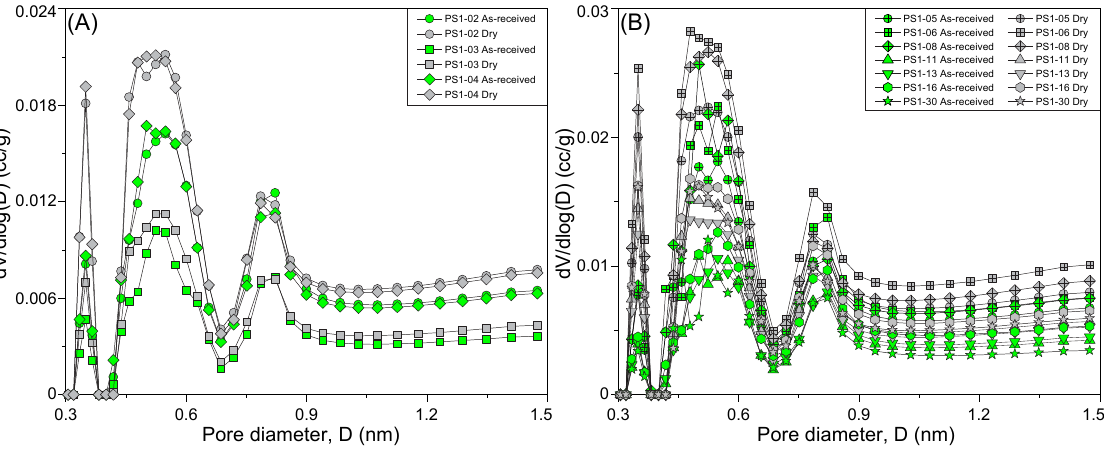
Figure 4. Pore size distribution calculated from the CO 2 adsorption isotherms of the as-received and dry shale samples from ( A ) the WF and ( B ) the LMX of the Well PS1.